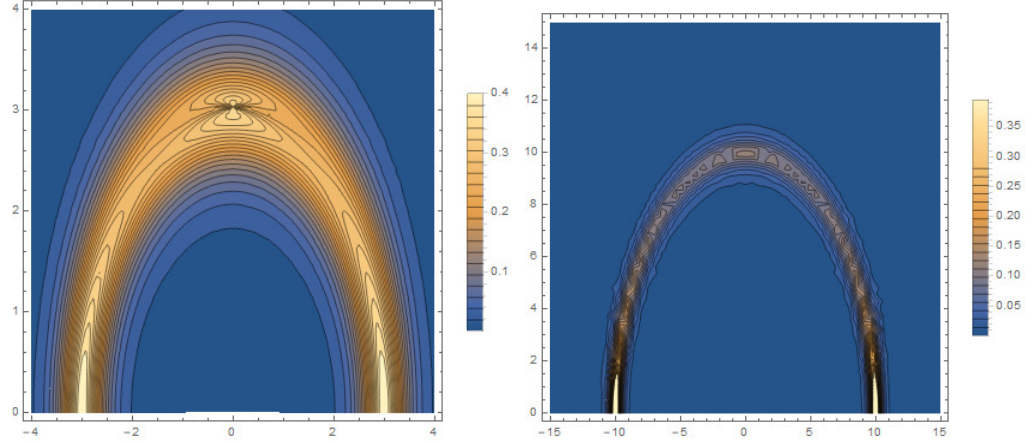
Figure 1 . The density of the renormalized volume form (cid:6) for M = 0 : 2 and (cid:11) = 0 : 5. The left plot corresponds to the time moment t = 3, and the right one to t =